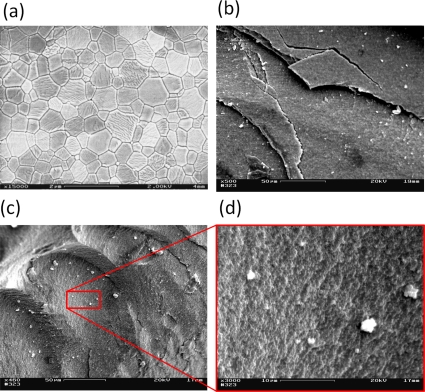
(a) Micrograph section of an etched Al2O3 ceramic surface exhibiting the granular structure on the microscale. (b) SEM photograph of the fracture surface of Al2O3 after edge-on impact experiment [18] with striking speed of v ≈ 400m/s. (c,d) Microstructural details of the Al2O3 surface exhibiting structural hierarchies. Figure by M.O. Steinhauser, Fraunhofer EMI.